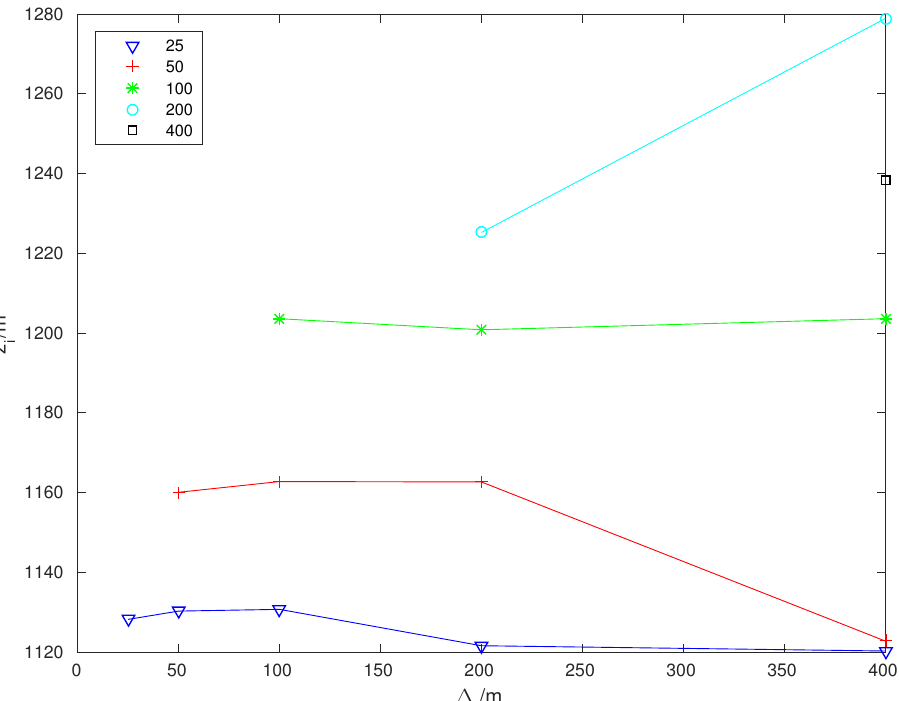
Figure 4. Boundary layer height diagnosed from each CBL2 simulation plotted at its native grid length and also when computed after coarse graining of the data onto other grids. The lines indicate coarse graining in all three